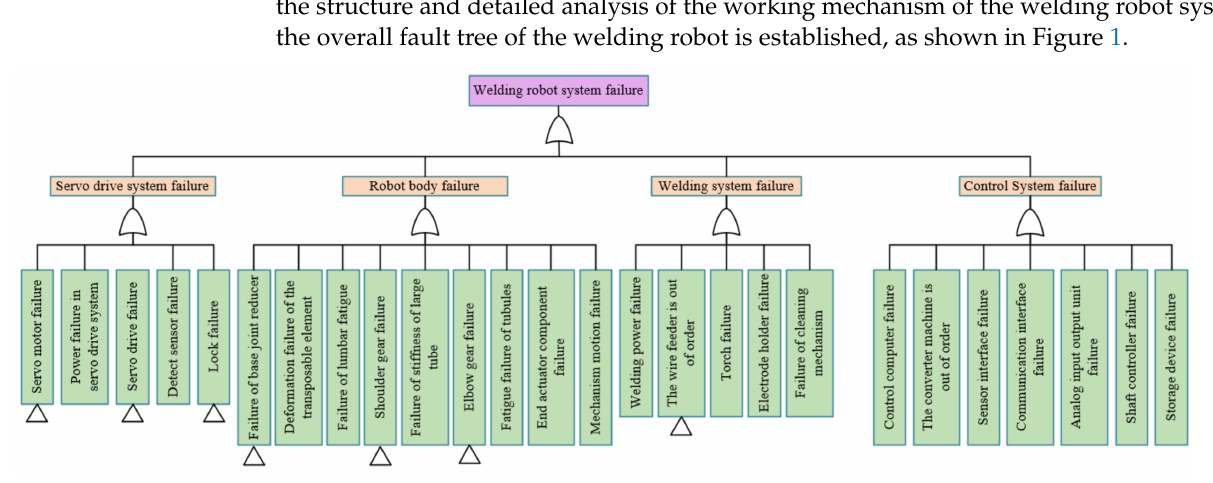
Figure 1. Welding robot system